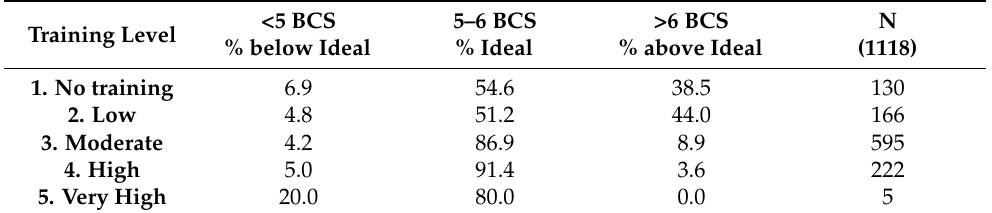
Table 8. Distribution of below ideal, ideal, and above ideal BCS for horses in relation to the training